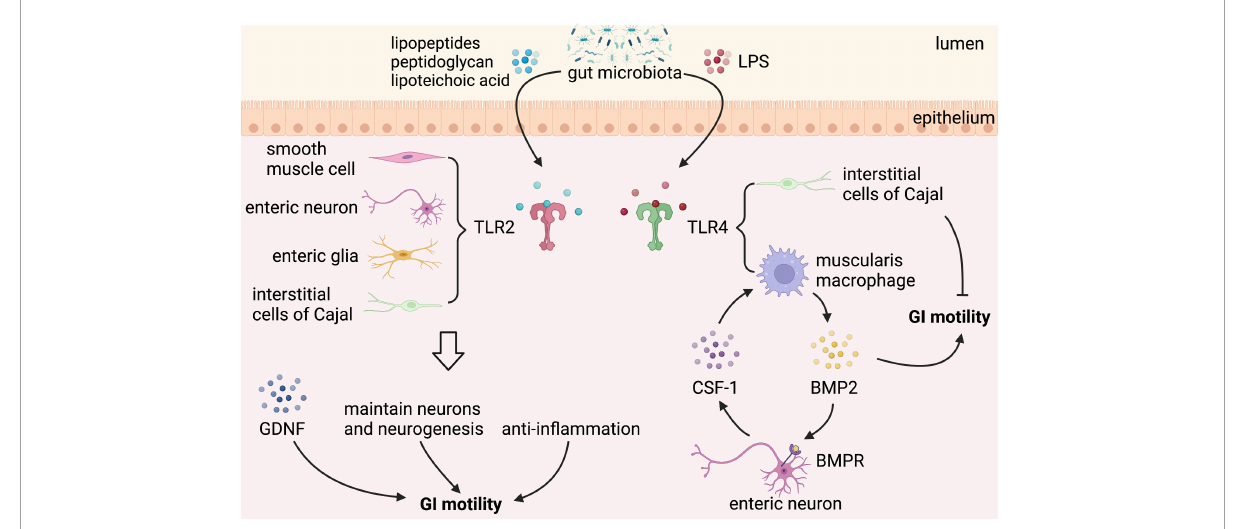
FIGURE3 Gut microbial components regulate gastrointestinal (GI) motility via binding to toll-like receptor 2/4. Toll-like receptors (TLRs) expressed in the GI tract sense gut microbial components take part in the regulation of GI motility. TLR2 is expressed on enteric smooth muscle cells, neurons, neuroglia, and interstitial cells of Cajal (ICCs). Lipopeptides, peptidoglycan, and lipoteichoic acid from gut microbiota binding to TLR2 stimulate the release of glial cell line-derived neurotrophic factor (GDNF), maintain neurons and neurogenesis, and play an anti-inflammation effect, which can improve GI motility. In addition to TLR2, TLR4 is the best-characterized receptor recognizing gut microbiota-derived Lipopolysaccharide (LPS). LPS binding to TLR4 expressed on muscularis macrophage (MM) stimulates the release of bone morphogenetic protein 2 (BMP2), which improves GI motility. In response to BMP2, enteric neurons produce colony stimulatory factor 1 (CSF-1), which in turn promotes MM homeostasis. However, LPS binding to TLR4 expressed on ICCs has a negative effect on GI